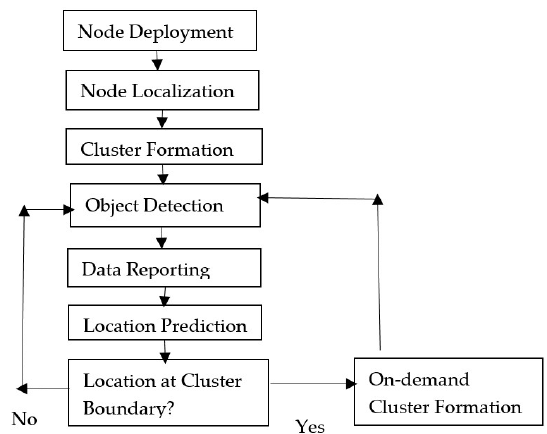
Figure 2. System architecture of EEODTF.